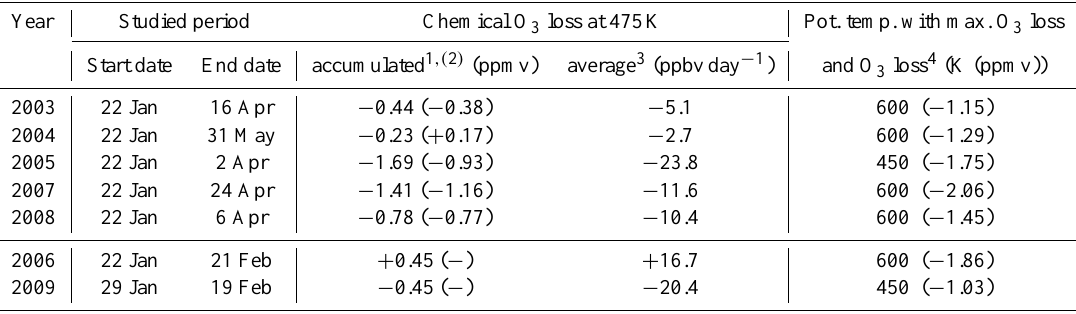
Table 1. The chemical ozone loss rates and accumulated ozone losses in the Arctic polar vortex between the 450K and 600K isentropic levels for the winters 2002/2003 to 2008/2009. The seasons with sudden stratospheric warmings are shown separately at the bottom of the table. Note that the ozone losses below about 550K potential temperature are mainly driven by reactive halogen compounds formed by heterogeneous reactions, whereas the losses above this level are driven by enhanced NO x and occur near the end of